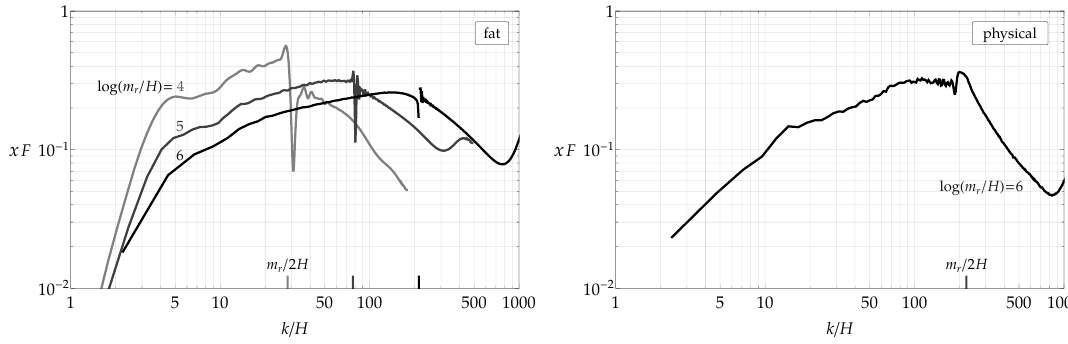
Figure 26 . Plot of xF ( x; y ) with x = k=H for the fat string (left) and the physical (right) cases, for di(cid:11)erent values of y = m r =H . The growth of xF ( x; y ) for x between the IR and UV cuto(cid:11)s corresponds to a UV dominated spectrum, i.e. q < 1.